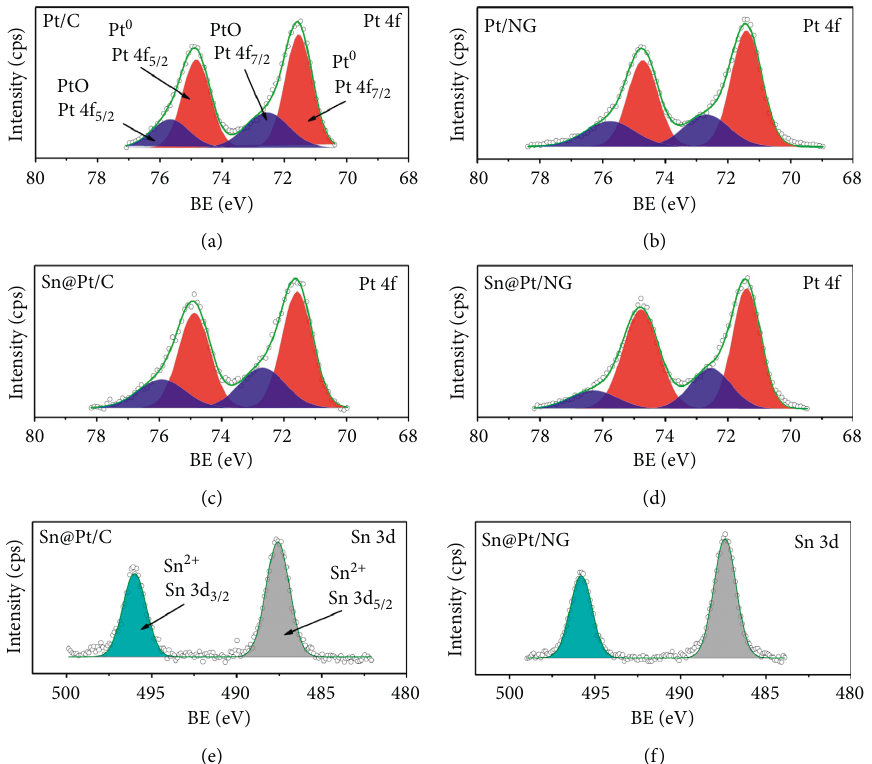
Figure 3: High-resolution XPS spectra in the Pt 4f region of (a) Pt/C, (b) Pt/NG, (c) Sn@Pt/C, and (d) Sn@Pt/NG. (e)-(f) High-resolution spectra in the Sn 3D region of Sn@Pt/C and